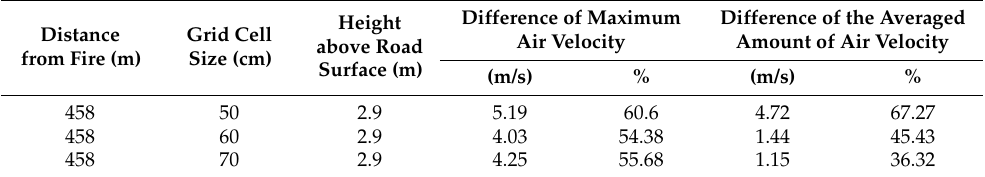
Table 5. Comparison between simulated and experimental values of air velocity.